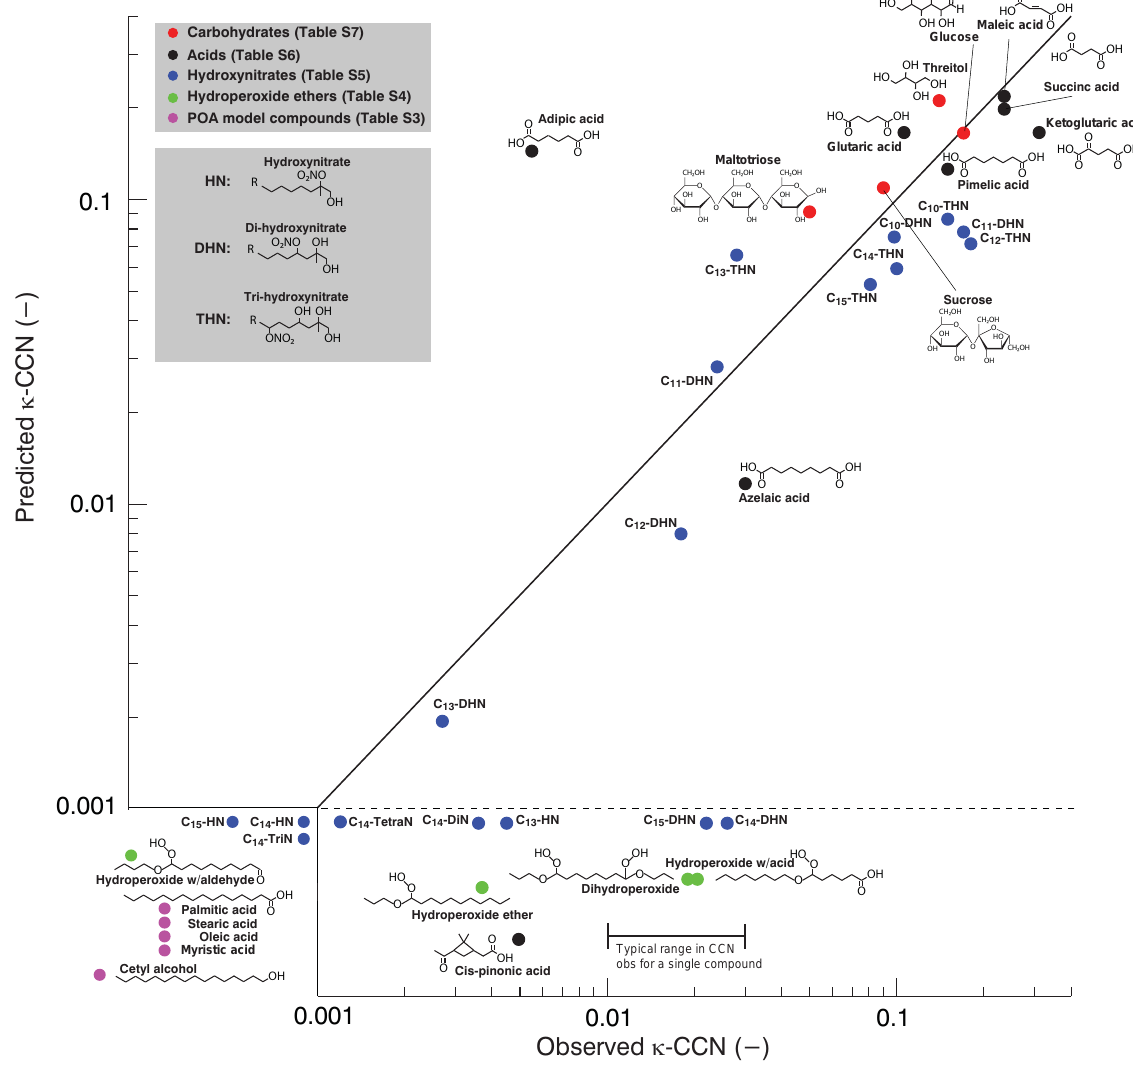
Figure 2. Model predicted vs. experimentally determined κ values. Values κ <0.001 are classified as CCN inactive and are clustered in the lower left corner of the graph. Colors are used to delineate the grouped source data in the Supplement. Selected structures from the Supplement are included in the graph. C x HN, C x DHN, and C x THN denote hydroxy nitrate, dihydroxy nitrate, and trihydroxy nitrate and x denotes the total number of carbon atoms. C 14 DiN, C 14 TriN, C 14 TetraN denote the C 14 dinitrate, trintrate, and tetranitrate, respectively. Points below the dashed line corresponds to compounds with predicted κ < 0 . 001 and observed κ > 0 . 001. Typical range of observed κ CCN for peroxides is indicated by the horizontal